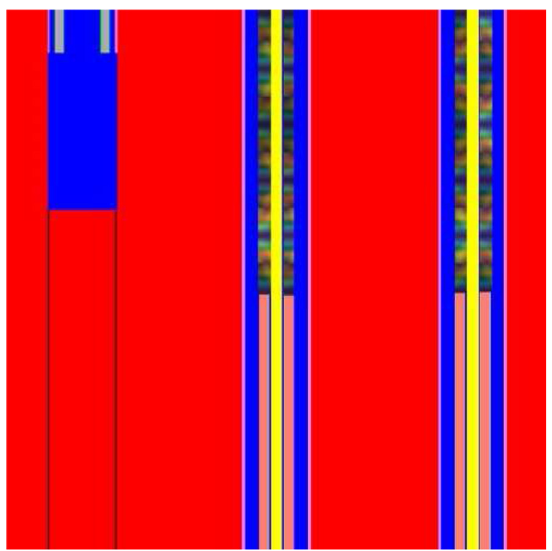
Fig. 10. Control rods are initially inserted with